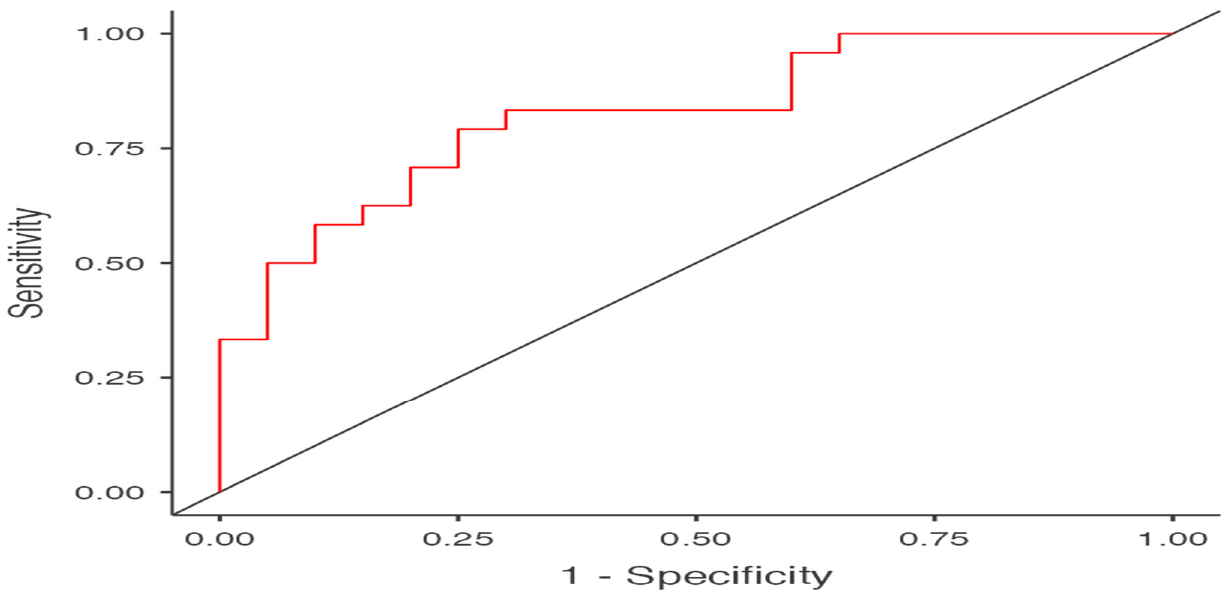
Figure 3. Receiver Operating Characteristic Curve.